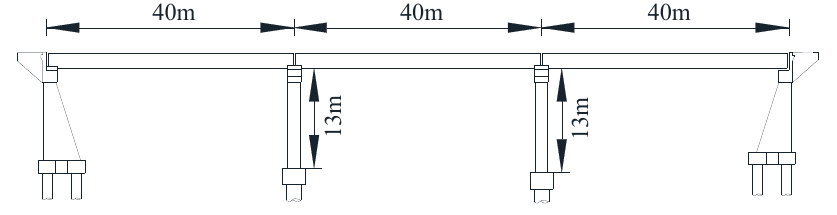
Figure 6. Elevation drawing of the benchmark bridge.